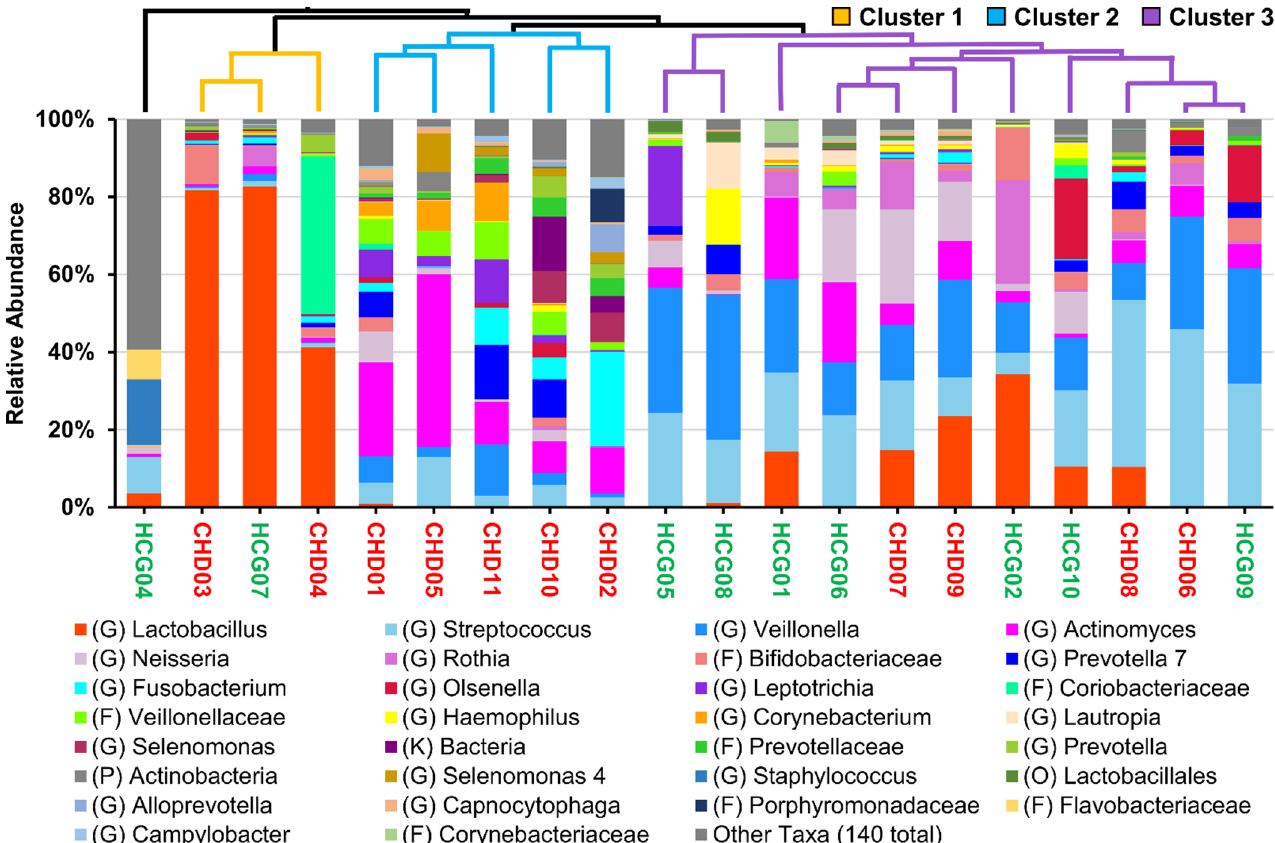
Figure 4. Cumulative bar charts showing the relative abundance of the top 30 taxa by the mean abundance of their highest classification level. Taxa not in the top 30 are summarized as ‘other Taxa’. The dendrogram on the top shows a tree based on the Bray–Curtis dissimilarity using the UPGMA algorithm [(G): genus; (F): family; (O): order; (P): phylum; (K): kingdom]. Sample name is given in red for CHD group and in green for HCG group.